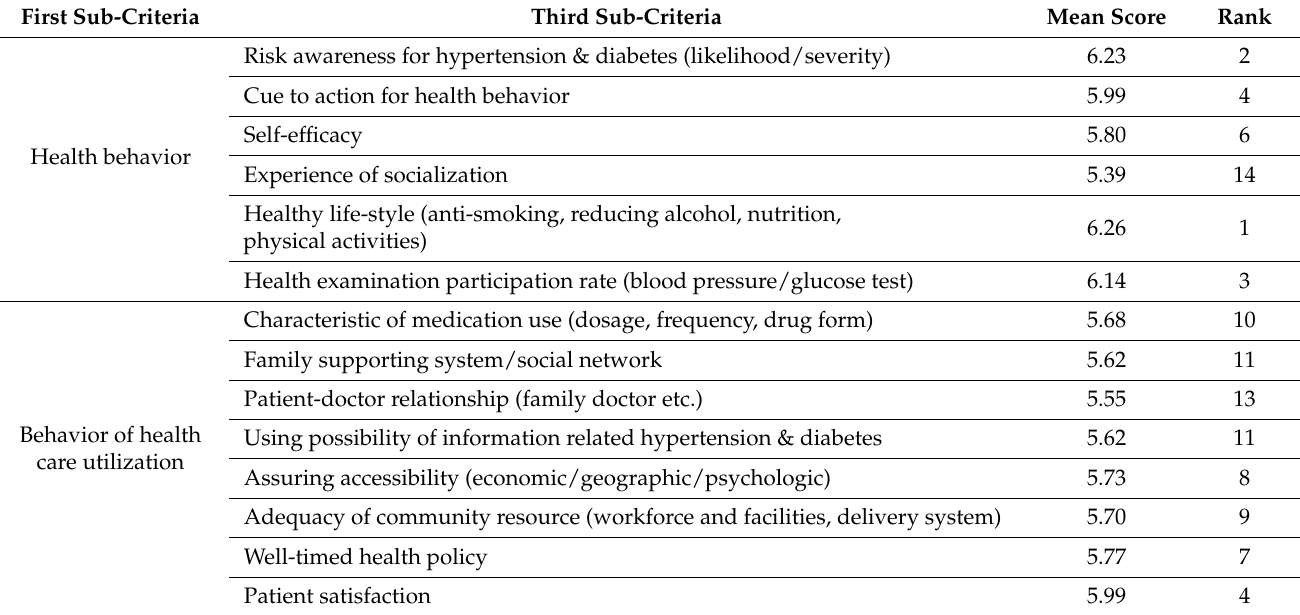
Table 2. Relative importance by evaluation criteria of community-based intervention program to approach strategy for patients (individual